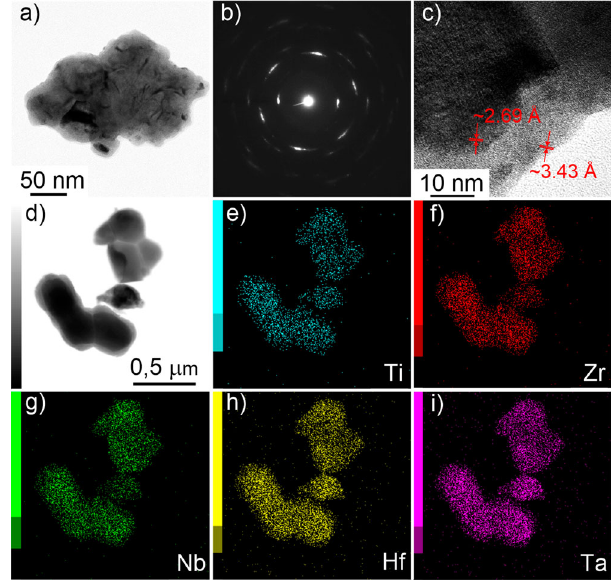
Fig. 6 Microscopy images of a single-phase sample. a TEM image, b SAED, c HRTEM lattice image, d STEM, e – i EDX elemental